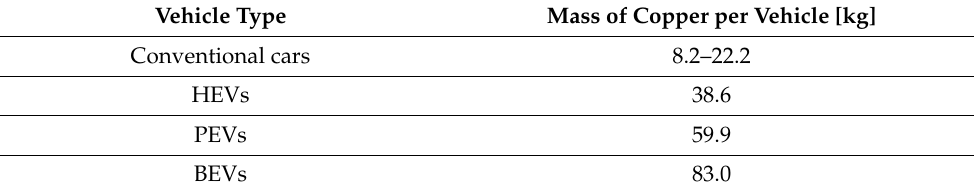
Table 15. Mass of copper per vehicle